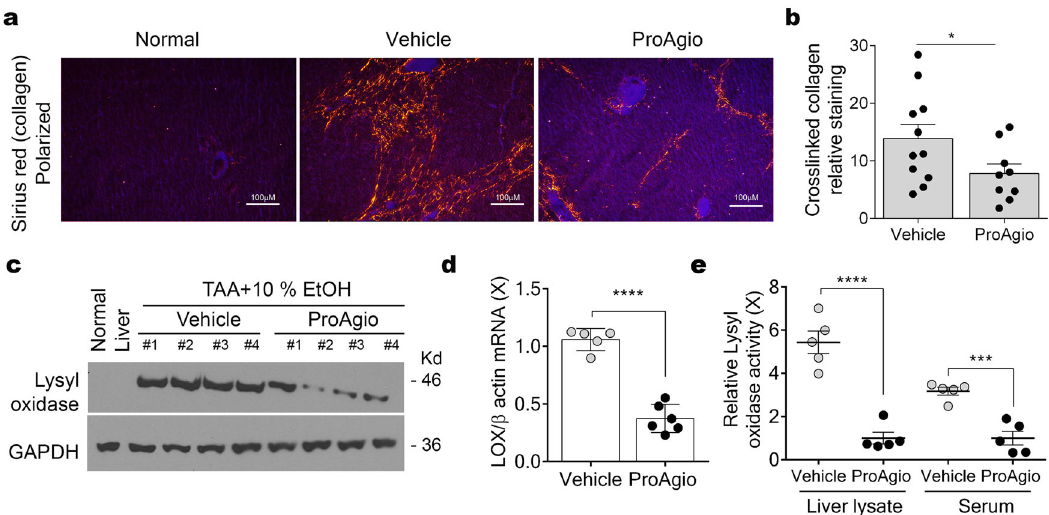
Fig. 4 ProAgio reduces collagen crosslinking in fi brotic liver. a Representative images of Sirius red staining of liver tissue sections from mice treated with indicated agents viewed under polarized light, indicating cross-linked collagen. Scale bars show 100 µ m. b Quantitation of collagen levels in Sirius red stain under polarized light using ImageJ software. The quantity of cross-linked collagen levels is presented as relative staining of sections from non- fi brotic mice as reference. Quanti fi cations of Sirius red stains under polarized light were calculated from measurements of 10 mice. Four randomly selected tissue sections per animal and three randomly selected view fi elds in each section were quanti fi ed. c , d Immunoblot ( c , Lysyl oxidase) and RT-PCR d analyses of LOX protein and mRNA levels in liver extracts of four and fi ve mice treated by indicated agents. Immunoblot of GAPDH (GAPDH) in c is a loading control. The mRNA levels are presented as a relative ratio compares to mRNA levels of β -actin. e LOX activity in liver lysate and serum of fi ve mice treated by indicated agents was measured by LOX activity kit. The LOX activity is presented as relative LOX activity of vehicle with respect to ProAgio by de fi ning the mean value of ProAgio-treated group as 1. Error bars in b are standard deviations of measurements of 10 mice. Normal in a is the mice without fi brosis induction and treatment. * P < 0.05; *** P < 0.001, **** P <